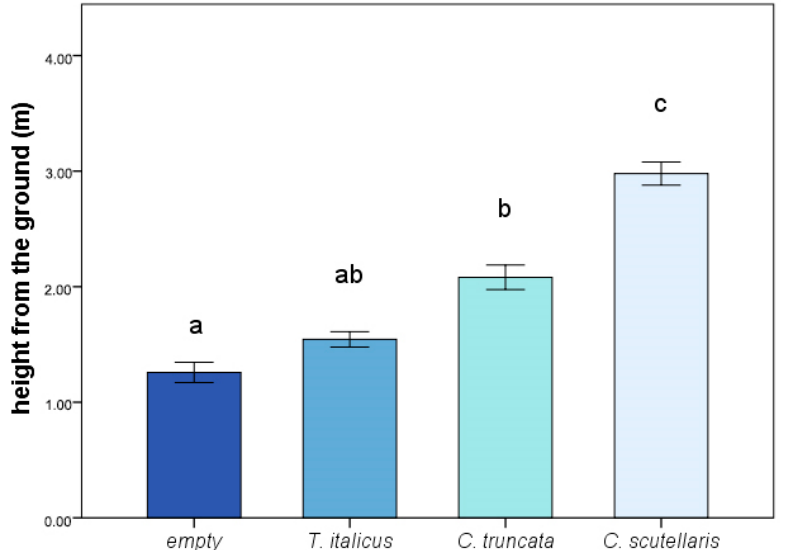
Figure 4. Gall occupancy according to position on the tree (height from the ground) and ant species. SE interval is shown for each bar. The bars with the same letter are not statistically different (one-way ANOVA and Tukey’s post-hoc tests).